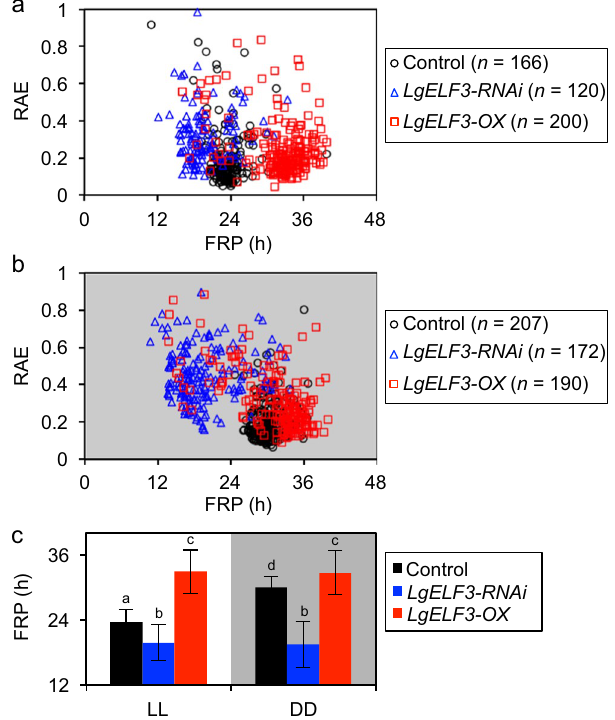
Figure 1. Changes in FRPs and RAEs of cellular AtCCA1::LUC rhythms caused by LgELF3 effectors under constant conditions. FRPs and RAEs of individual cellular rhythms under LL ( a ) and DD ( b ) are plotted for the control vector ( pBI221 Δ GUS , black circles), the knockdown LgELF3-RNAi construct (blue triangles) and the overexpressing LgELF3-OX construct (red squares). Three independent experiments for each condition were conducted, and the total samples were plotted. ( c ) Comparison of FRPs shown in ( a ) and ( b ) for bioluminescence traces with RAE values less than 0.4. Data are expressed as mean ± SD values. Means with the same letters are not significantly different. * p < 0.01, significant differences between the mean values are based on a two-level nested ANOVA model with six groups [effector constructs (control, LgELF3-RNAi , LgELF3-OX ) under LL or DD], and subgroups (individual plants in the three experiments) nested within the